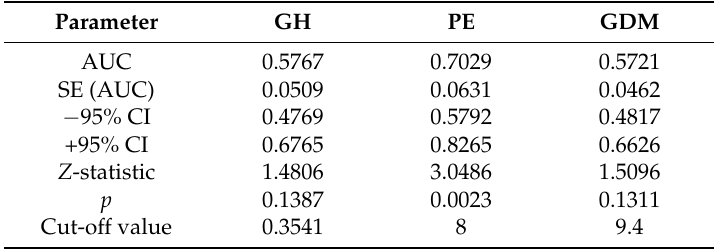
Table 3. Relationships between serum concentrations of 25(OH)D and the incidence of pregnancy-induced hypertension (PIH); gestational hypertension (GH); preeclampsia (PE); gestational diabetes mellitus (GDM); results of ROC (receiver operating characteristic)